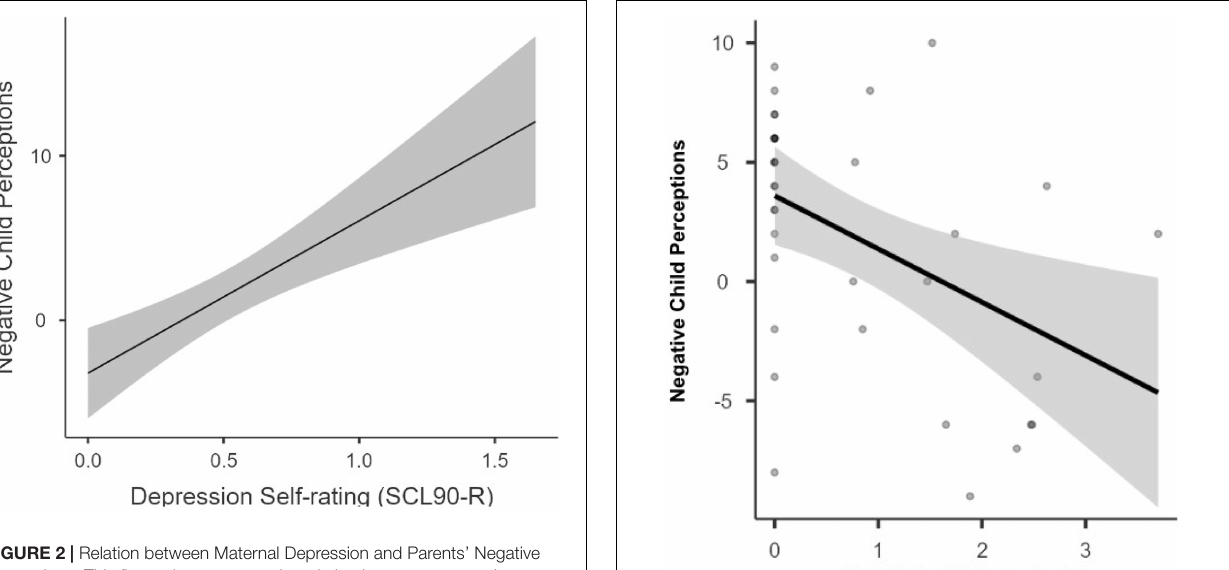
FIGURE 2 | Relation between Maternal Depression and Parents’ Negative Perceptions. This figure demonstrates the relation between maternal depression self-rating scores (SCL90-R) and subsequent parent negative perceptions toward their child (EMQ-X) at around 3 months postpartum.